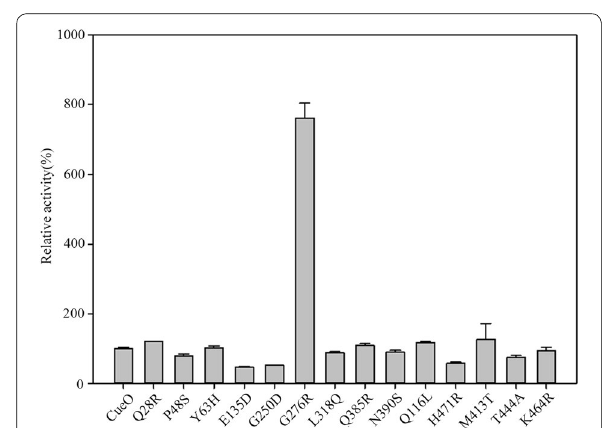
Fig. 3 Relative laccase activity of single-point mutants of CueO compared to wild type at pH 4.5 and 60 °C. The activity of the G276R mutant was about sevenfold higher than that of the wild- type enzyme. The relative laccase activity in the supernatants was determined using standard enzyme assays and shown on the y -axis. Enzyme activity is expressed as the mean of three samples, and error bars indicate standard